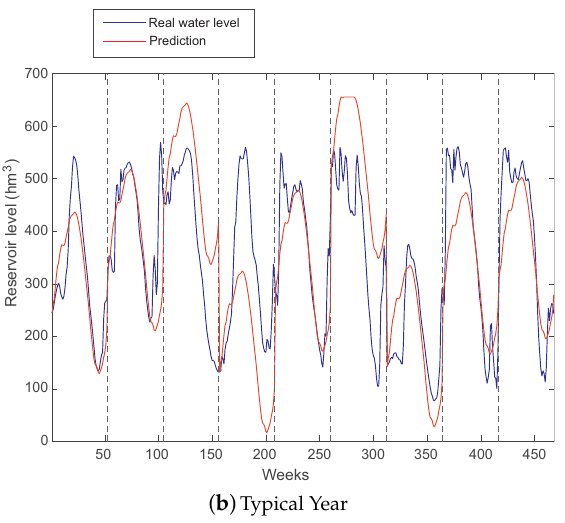
Figure 6. AR(9) and typical year persistence-based long-term predictions for Belesar reservoir water